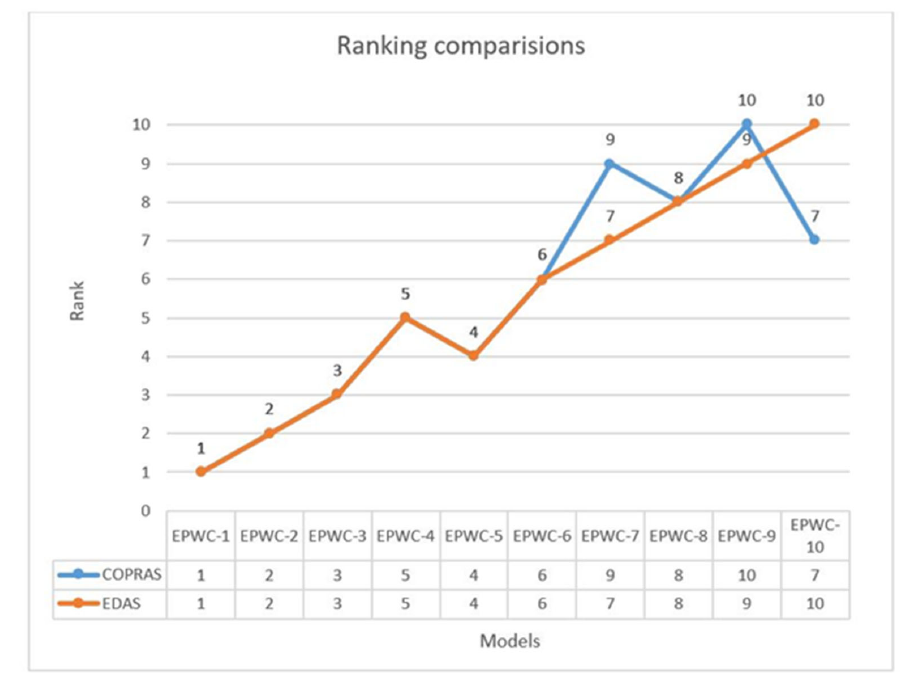
Fig.3. Ranking Comparisons of the electric power wheelchair models by COPRAS and